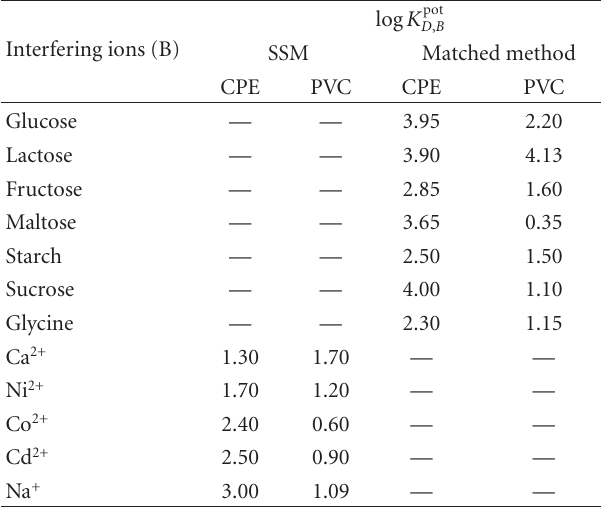
Table 1: Potentiometric selectivity coe ffi cient of CPE (DOS) and PVC (DOS) membrane electrodes.